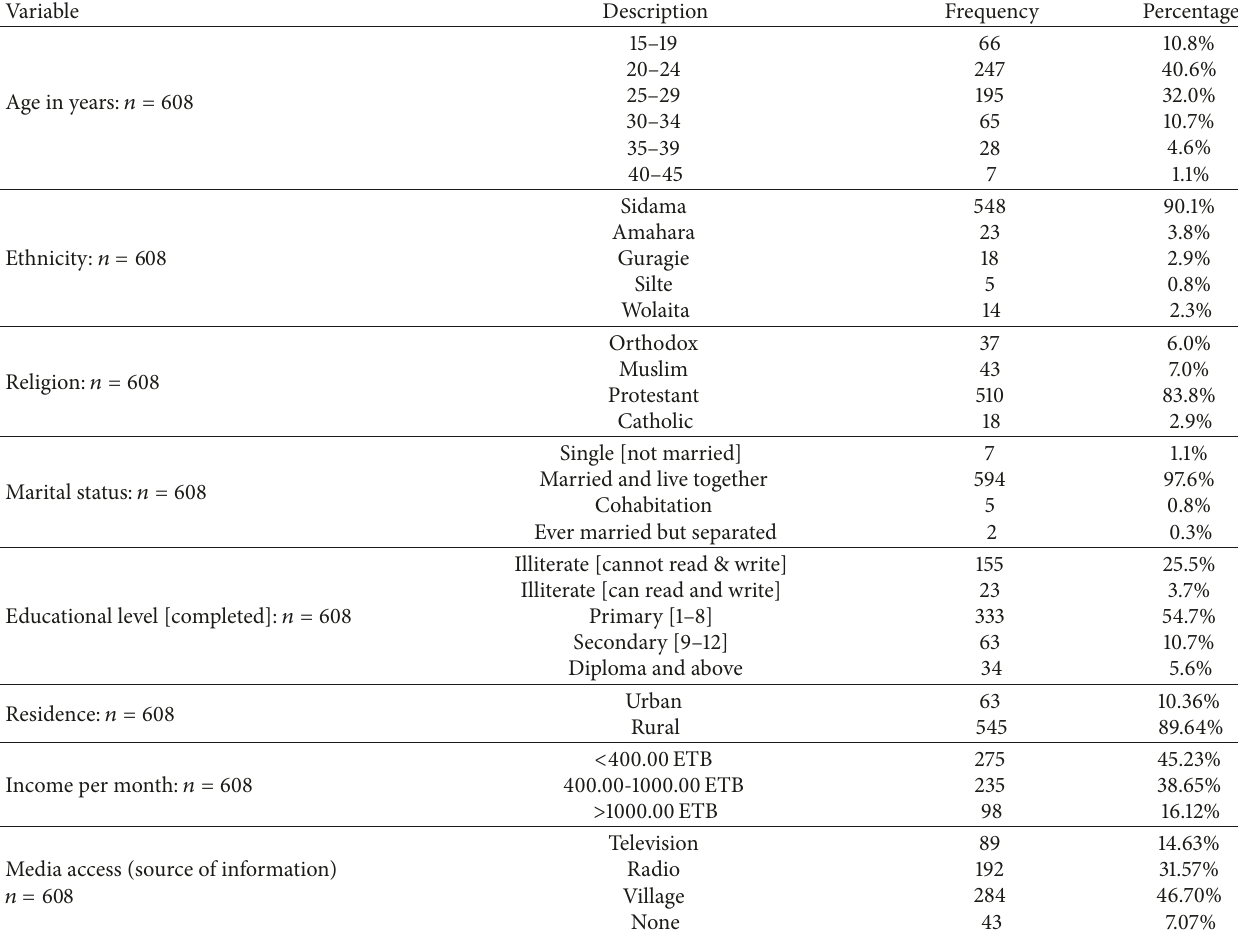
Table 1: Sociodemographic characteristics of respondents by time of ANC booking in Shebedino district in 2015. Variable